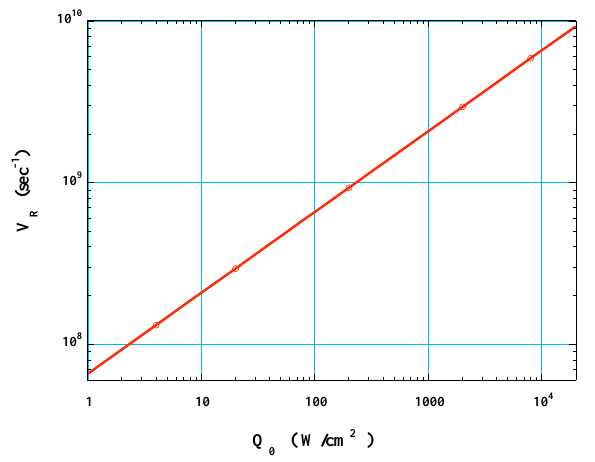
FIG. 3. (Color) (cid:81) (cid:48) dependence of Rabi frequency (cid:86) (cid:82) . atoms into the (cid:51) (cid:80) state. When (cid:76) is the length over which